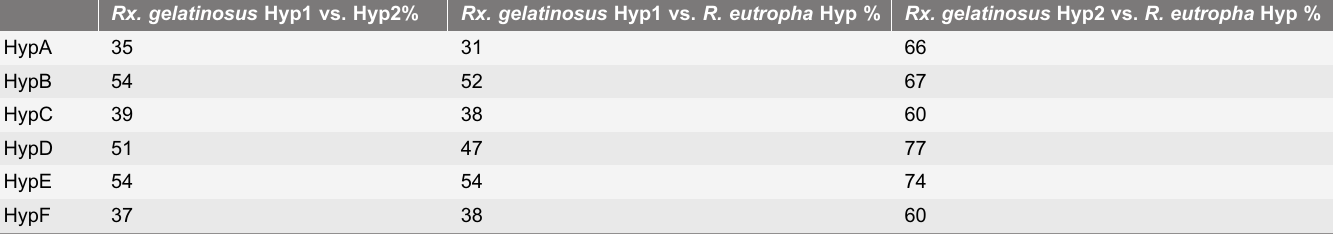
Table 3. Identity percentage of Rubrivivax gelatinosus CBS Hyp1, Hyp2 proteins and the Hyp proteins from Ralstonia eutropha H16, generated by NCBI P- BLAST search. Rx. gelatinosus Hyp1 vs.